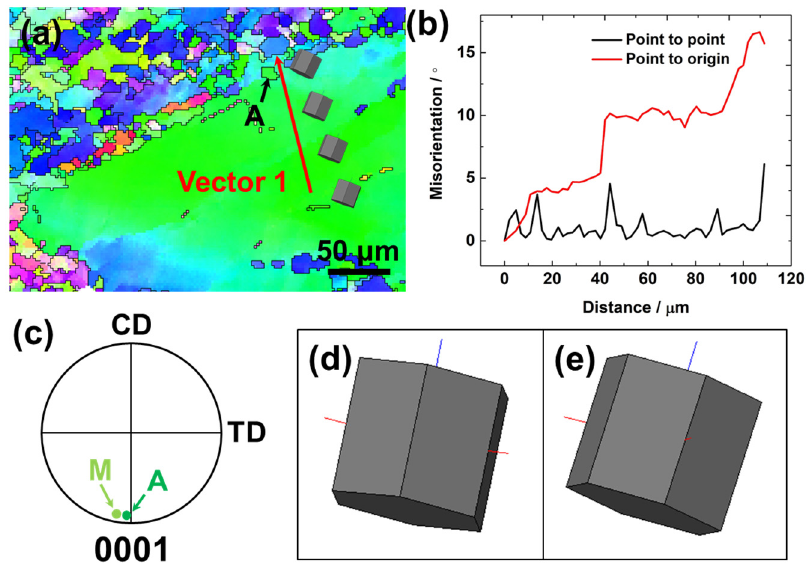
Figure 11. ( a ) EBSD IPF map of the alloy deformed at 300 ◦ C/0.01 s − 1 , ( b ) changes of misorientations along vector 1, ( c ) the orientations relationship on {0001} pole figures of nuclei A with its surrounding matrix grain and schematic diagram showing the lattice of nuclei ( d ) A and ( e ) matrix grain.